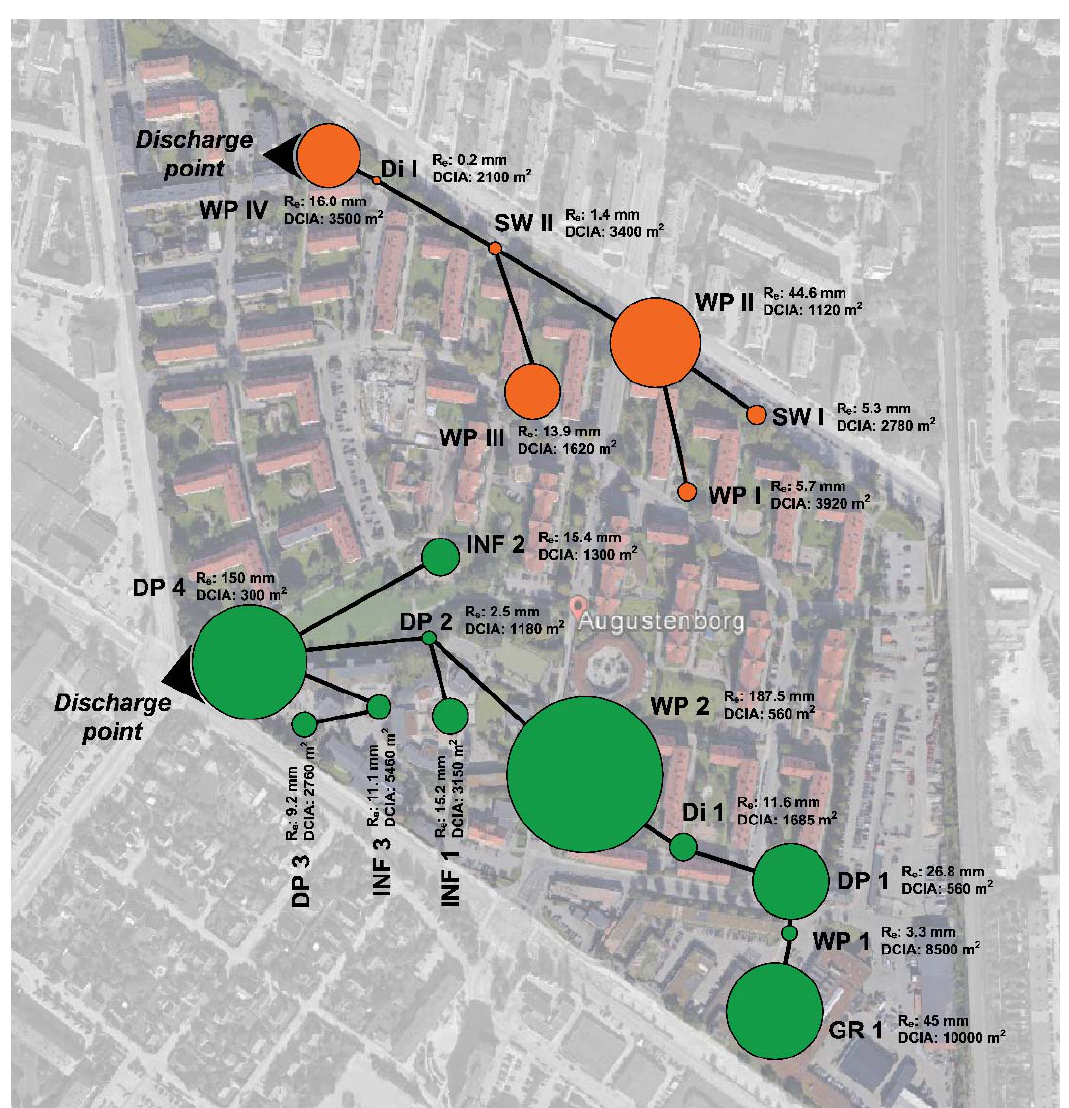
Figure 7. Conceptual illustration of Northern SuDS (top) and Southern SuDS (bottom) in Augustenborg. Each SCM is represented as a circle. The size of the circle corresponds to the effective retention capacity of the SCM, i.e., R i e . Please notice that the SCMs belonging to the Northern SuDS are indexed with Roman numerals while SCMs in the Southern SuDS are numbered with Arabic numerals. The size of the circle representing SCM is an indicator of its effective detention depth (sizes are not proportionally correct). The background picture is acquired from Google Earth.